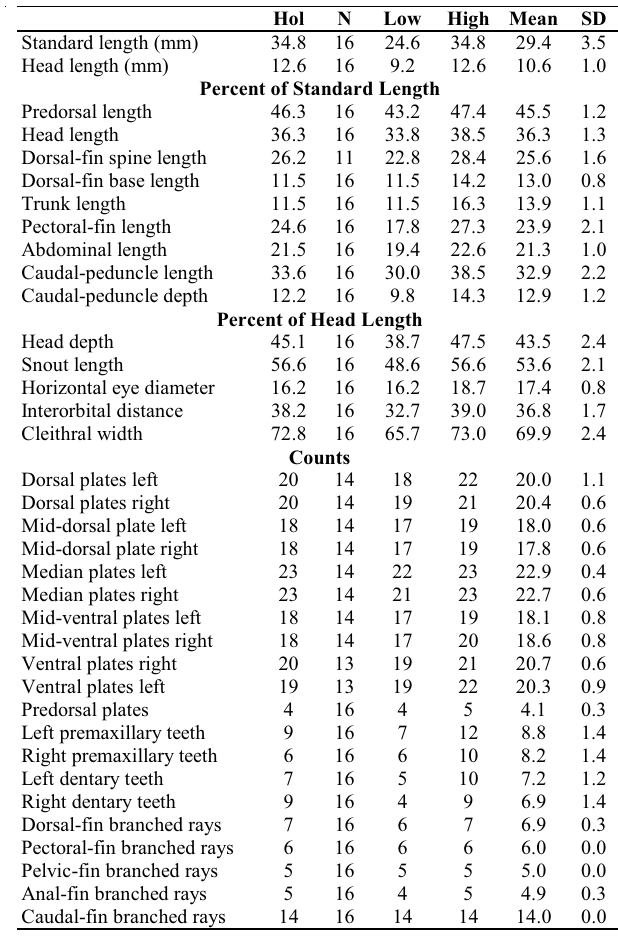
Table 1. Morphometric and meristic data for Parotocinclus bidentatus . Hol =